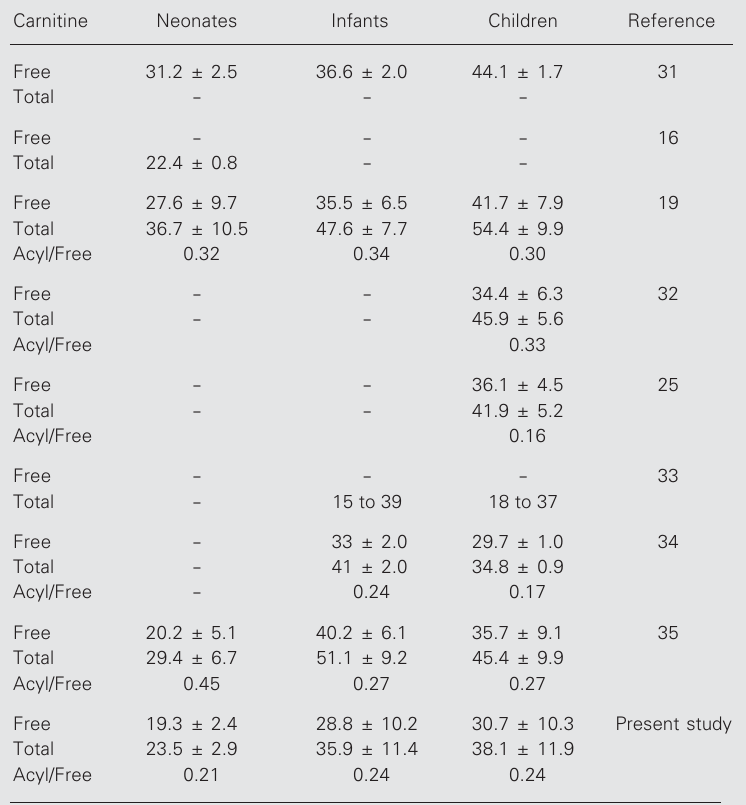
Table 3. Pediatric reference values for free and total carnitine (µM) in plasma and the acylcarnitine/free carnitine ratio.